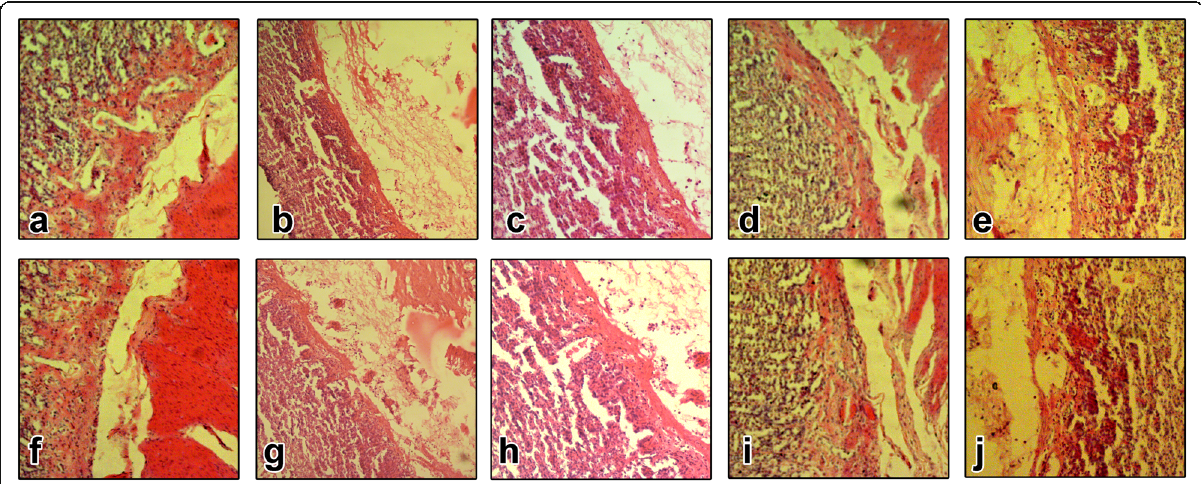
Fig. 4 Representative images for histopathological evaluation of inner gastric surface of Wistar albino rats subjected to alcohol-induced (plate ‘ a ’ to ‘ e ’ ) and acetic acid-induced antiulcer model (plate ‘ f ’ to ‘ j ’ ) at × 100 magnification. a Normal control group. b Diabetic control. c HAEGL (250 mg/kg). d HAEGL (500 mg/kg). e